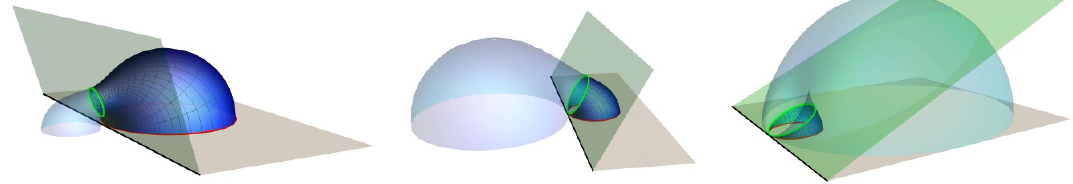
Figure 10 . Extremal surfaces ^ (cid:13) con anchored to a disk of radius R (bounded by the red circle) at A (cid:12)nite distance d from the (cid:13)at boundary (see section 4.2). Here d=R (cid:24) 0 : 042 is (cid:12)xed and di(cid:11)erent values of (cid:11) are considered: (cid:11) = (cid:25)= 2 : 5 (left), (cid:11) = 2 (cid:25)= 3 (middle) and (cid:11) = 2 : 7 (right). The surface ^ (cid:13) con intersects the green half plane Q orthogonally along the green circle @ ^ (cid:13) Q . The shaded surfaces A correspond to the auxiliary surfaces ^ (cid:13) con (see also appendix D). The extremal surface ^ (cid:13) con is the A; aux A global minimum when the corresponding F A is larger than 2 (cid:25) . Here F A = 5 : 6 (left), F A = 17 : 1 (middle) and F A = 47 : 1 (right). The surface in the left panel has the smallest area among the two solutions ^ (cid:13) con but the global minimum is the hemisphere ^ (cid:13) dis in this A A